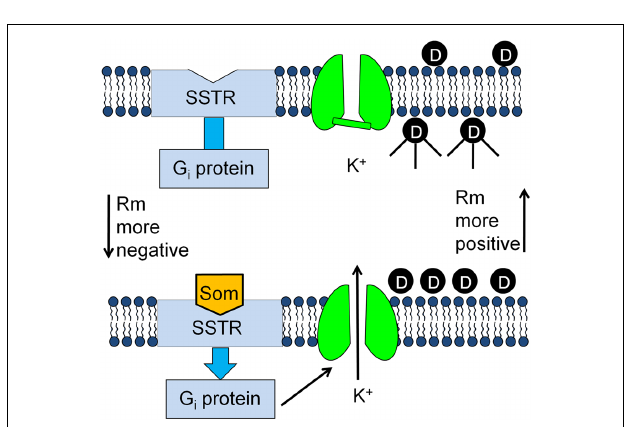
FIGURE 1 | Expression of GIRK channels inAtT20 cells. Left panel: Currents were measured before (control) and after the addition of somatostatin (200nM) during voltage steps applied from the holding potential of − 40 to − 60, − 80, and − 100mV. Addition of tertiapin (500nM) inhibited the current (bottom records).The solid lines represent zero current.Top right panel: I/V relationship for the somatostatin activated current (Som) displayed inward rectification and a reversal potential of